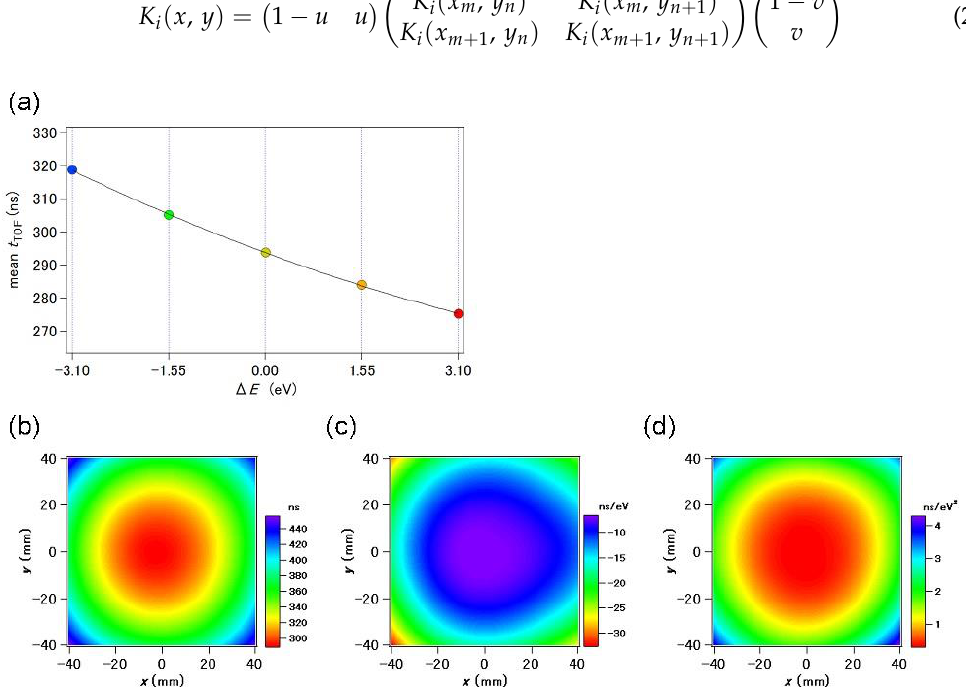
Figure 6. ( a ) Dependence of the mean values of t TOF of the electrons scattered by Ne atoms at ( x , y ) = (5 mm, − 5 mm) on the incident electron kinetic energy. Filled circles with different colors are the mean t TOF values at E i /eV = 1000 + 1.55 n with n = +2 (red), n = +1 (orange), n = 0 (yellow), n = − 1 (green), and n = − 2 (blue). A black solid curve represents a best-fit curve represented by the second-order polynomial expansion of Equation (1). ( b – d ) Position dependences of the coefficients, ( b ) K 0 ( x m , y n ), ( c ) K 1 ( x m , y n ), and ( d ) K 2 ( x m , y n ), in the second order polynomial (Equation (1)).